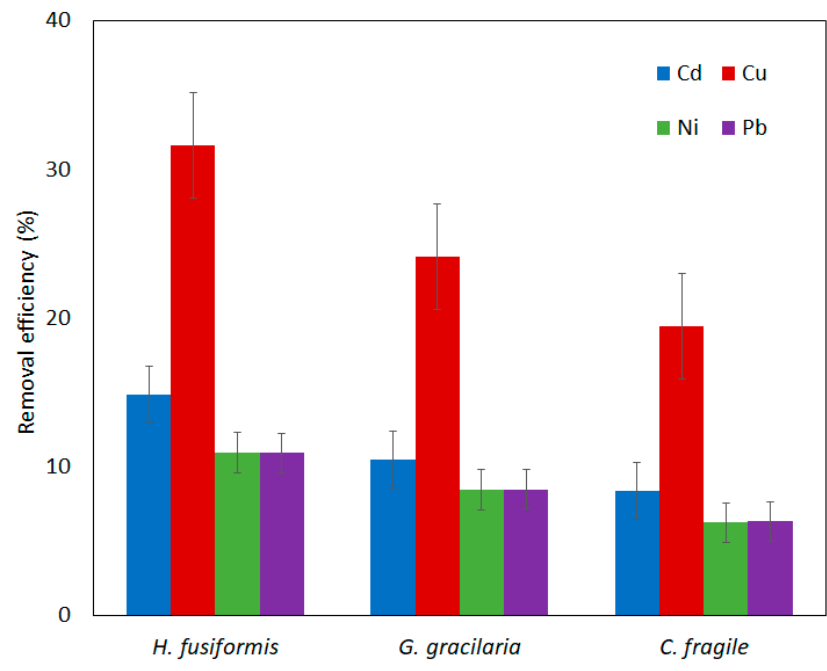
Figure 1. Comparison of metal removal capacity of biomass from different species of algae.